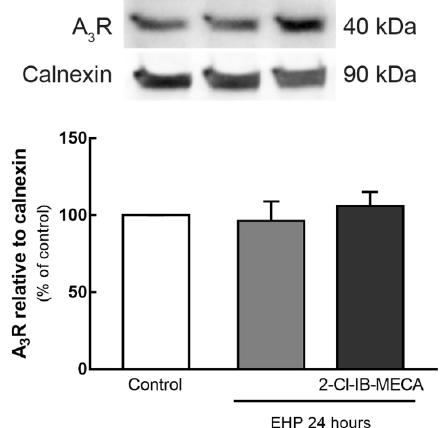
Figure 1. E ff ect of elevated hydrostatic pressure (EHP) on the expression of adenosine A 3 receptor (A 3 R) in BV-2 cells. Cells were exposed to EHP for 24 h. A 3 R protein levels were assessed by Western blot and results are expressed as percentage of control from 3 independent experiments. Representative images for A 3 R and calnexin are presented above the graph. Full length uncropped images are presented in Supplementary Figure